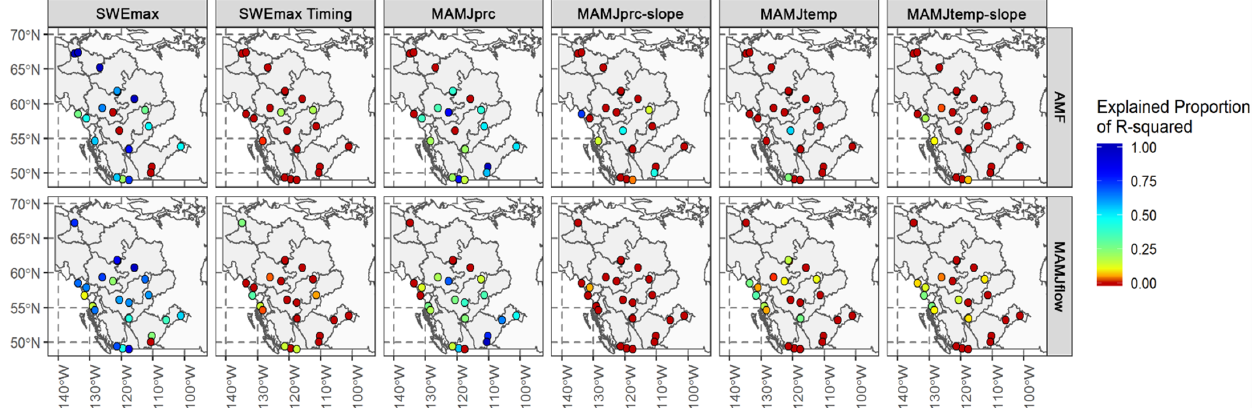
Figure 5. Spatial distribution of predictors’ relative importance in predicting annual maximum flow (AMF) and mean spring flow (MAMJflow) at each station over western Canada expressed as the proportion of the total explained variance (R 2 ) contributed by each predictor.